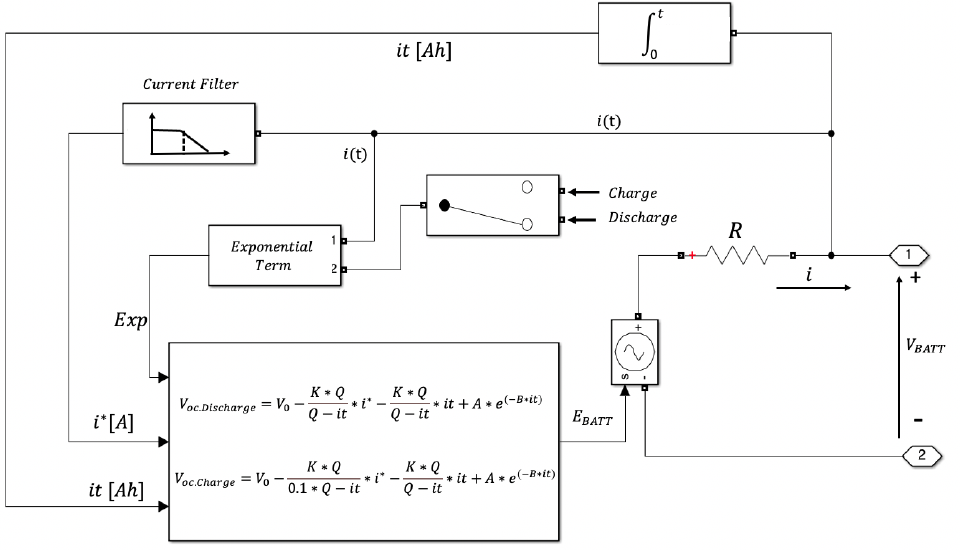
Figure 7. Schematic diagram of the battery